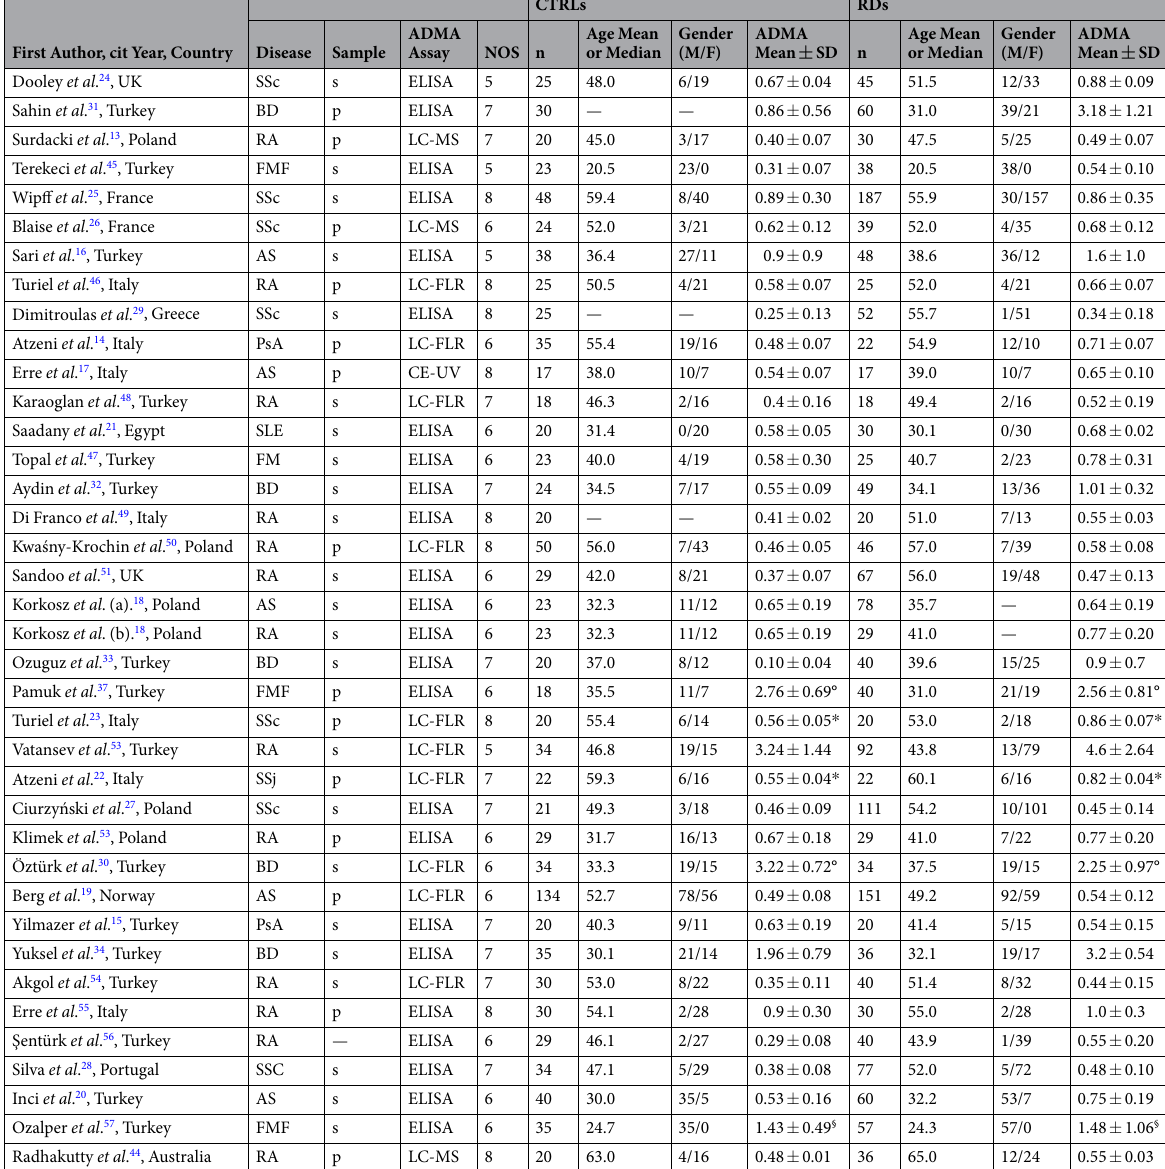
Table 1. Summary of the studies on controls vs subjects with rheumatic diseases included in the meta- analysis. NOS: Newcastle–Ottawa quality assessment scale for case-control studies (number represent stars). S, serum; p, plasma; LC, liquid chromatography; MS, mass spectrometry; FLR, fluorimetric; CE-UV, capillary electrophoresis UV detection. * Mean and standard deviation were estimated from the median and IQR. °Mean and standard deviation were estimated from the median and range. § Calculated from ng/dL. CTRLs, controls. RDs, rheumatic diseases. SSc, systemic sclerosis; BD, Behcet’s disease. RA, rheumatoid arthritis; FMF, familial Mediterranean fever; SSc, systemic sclerosis; AS, ankylosing spondylitis; PsA, psoriatic arthritis; SLE, systemic lupus erythematosus; FM,